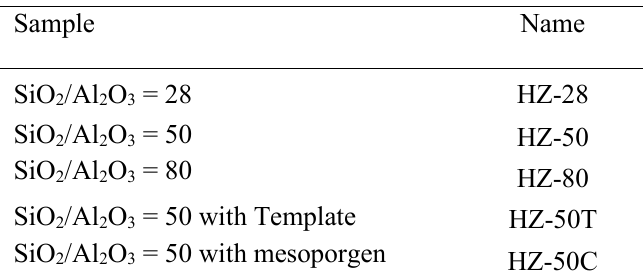
Table. 1. Name of the synthesized sample Table 1. Name of the synthesized sample.